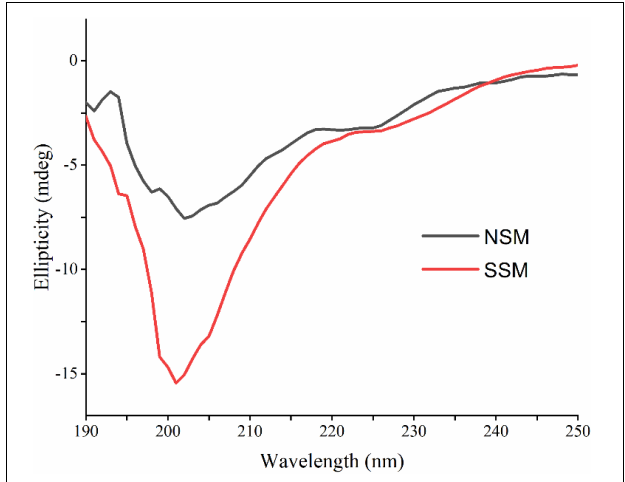
FIGURE 6 | Circular dichroism spectra of native and steam-exploded soybean meal proteins. NSM, native soybean meal; SSM, steam-exploded soybean meal.